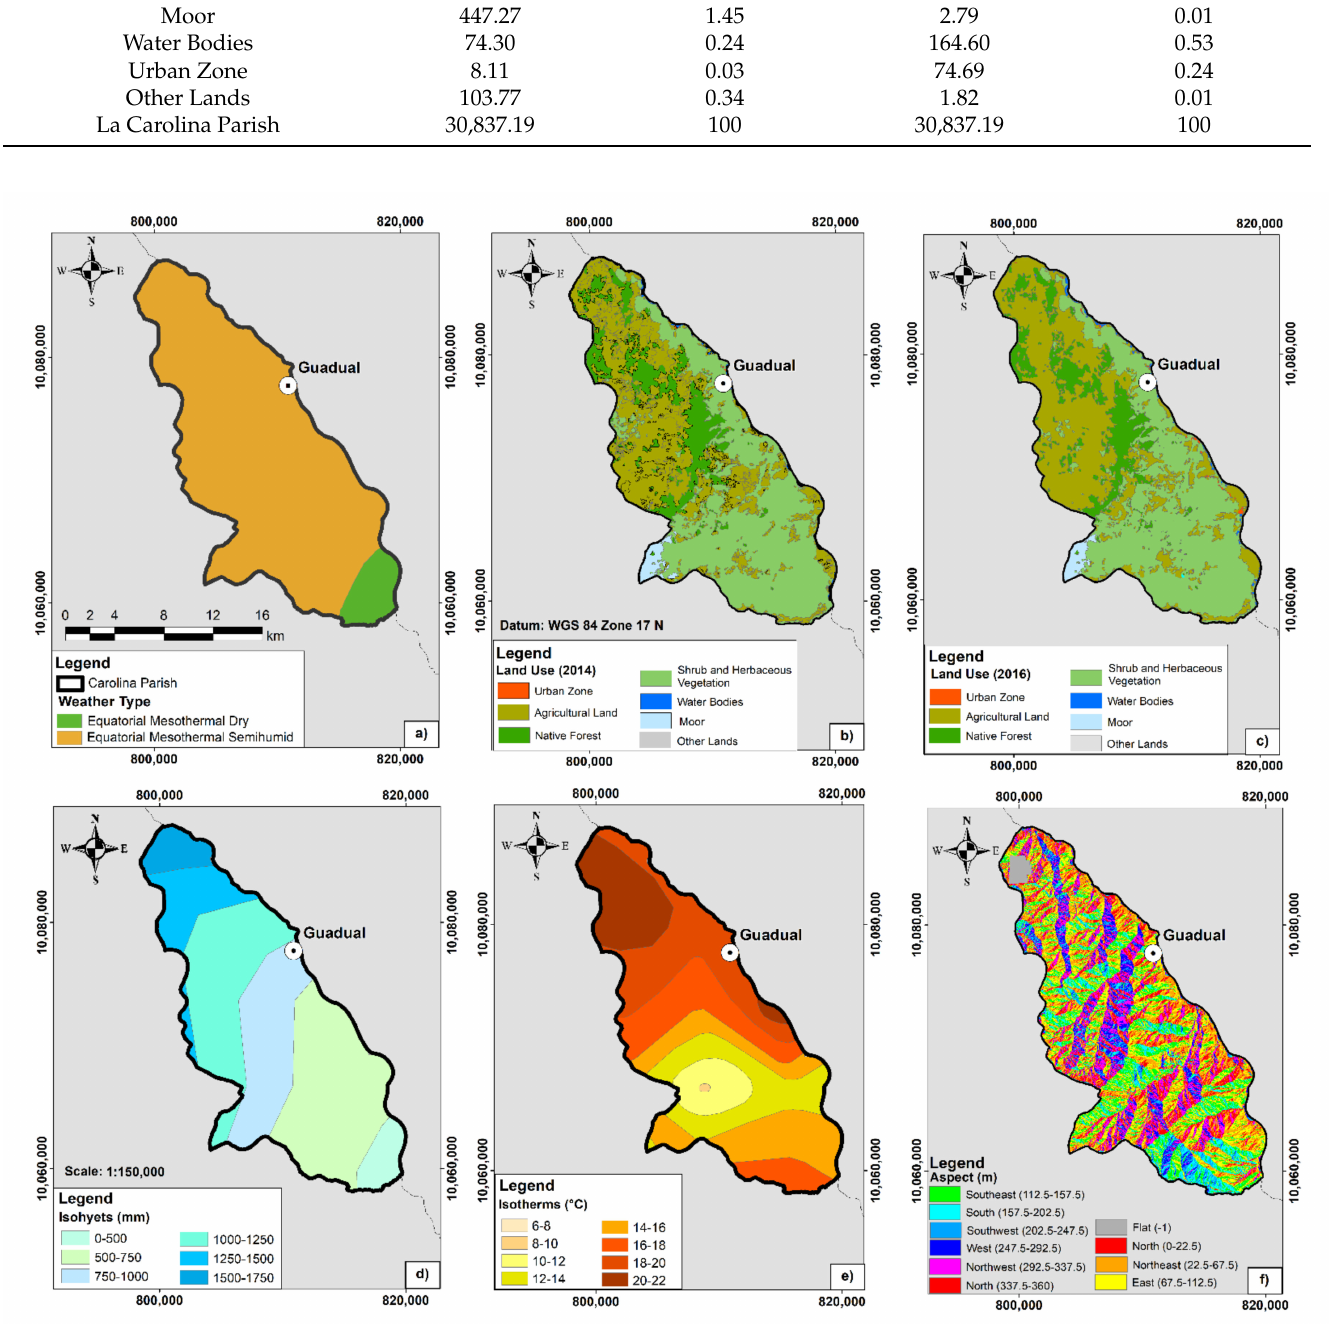
Figure 4. Base information of La Carolina parish. ( a ) climate type; ( b ) land use in the pre-fire scenario (2014); ( c ) land use in the post-fire scenario (2016), ( d ) isohyets, ( e ) isotherms, and ( f ) aspects or sun orientation. Source: adapted from